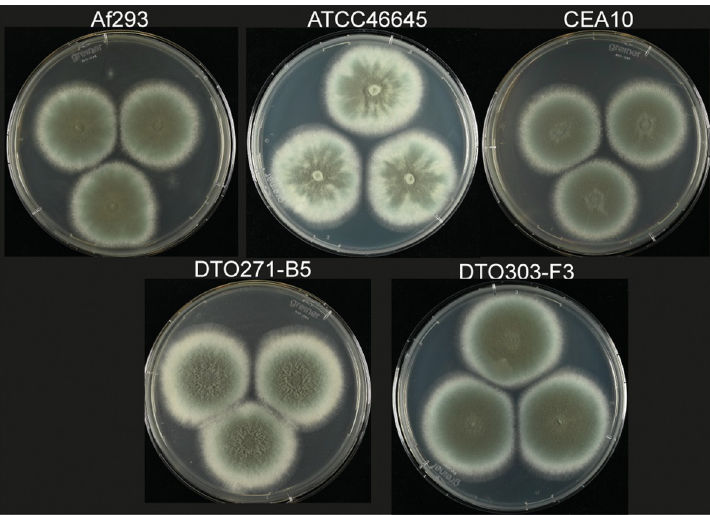
Fig 1. Colony size of A . fumigatus isolates grown for 2 days on potato dextrose agar (PDA) at 37˚C.